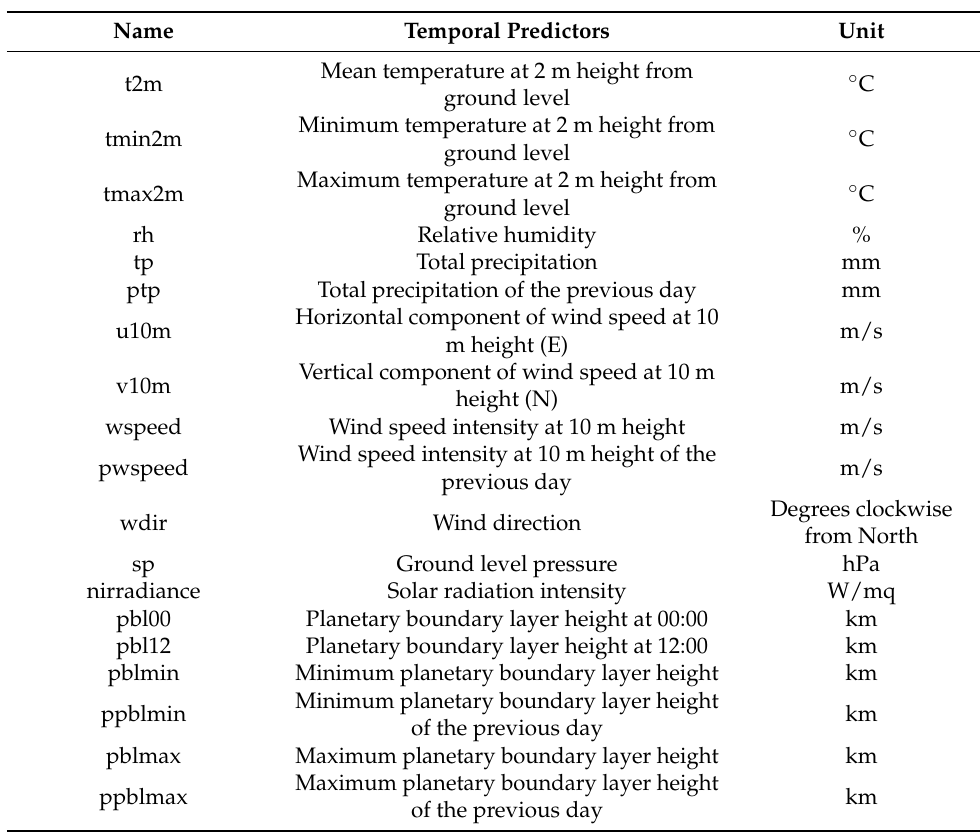
Table 2. Meteorological variables used for the GAMM